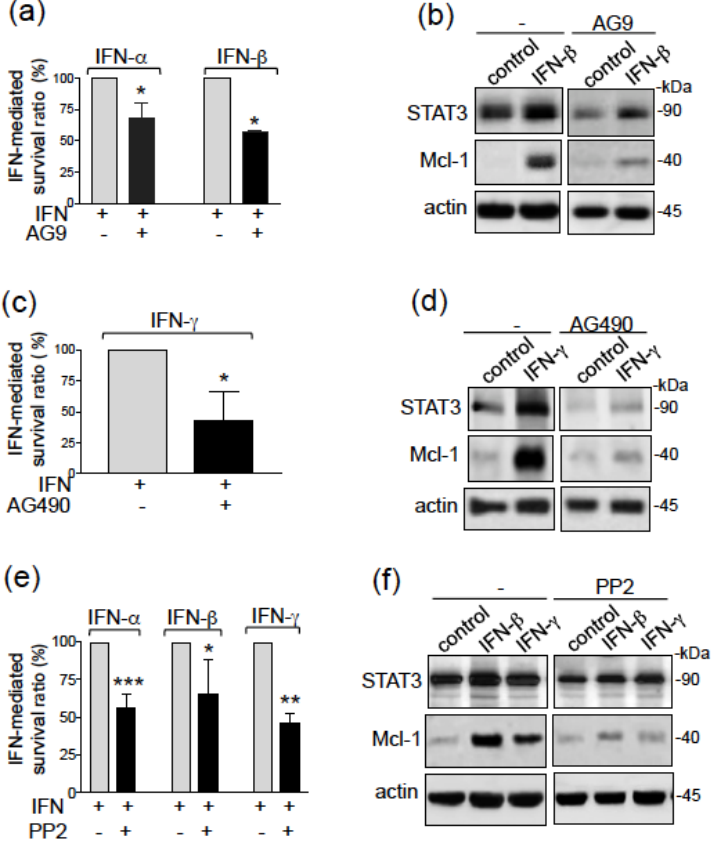
Figure 3. Type I and II IFNs induce CLL cell survival through the TYK2/Src and JAK2/Src signaling pathways respectively. ( a – f ) CLL cells were cultured for 24 h in the presence or absence of IFNs (1000 U/mL) after a 15 min pretreatment with ( a , b ) 10 µ M AG9, ( c , d )10 µ M AG490 or ( e , f ) 10 µ M PP2: ( a , c , e ) IFN-mediated cell survival was assessed as described in Figure 2; the survival of IFN- treated cells in the absence of the inhibitor is considered as a ratio of 100%; the data are presented as mean ± SEM ( n = 2 for AG9; n = 4 for AG490; n = 4 for PP2); statistical relevance was assessed with the paired t -test. ( b , d , f ) Lysates were Western blotted (reducing conditions) with antibodies against STAT3, Mcl-1 and actin; representative experiments are shown. * p < 0.05; ** p < 0.01; and *** p < 0.001. Whole blots relative to the Western Blotting analyses are presented in Supplemental File Figure